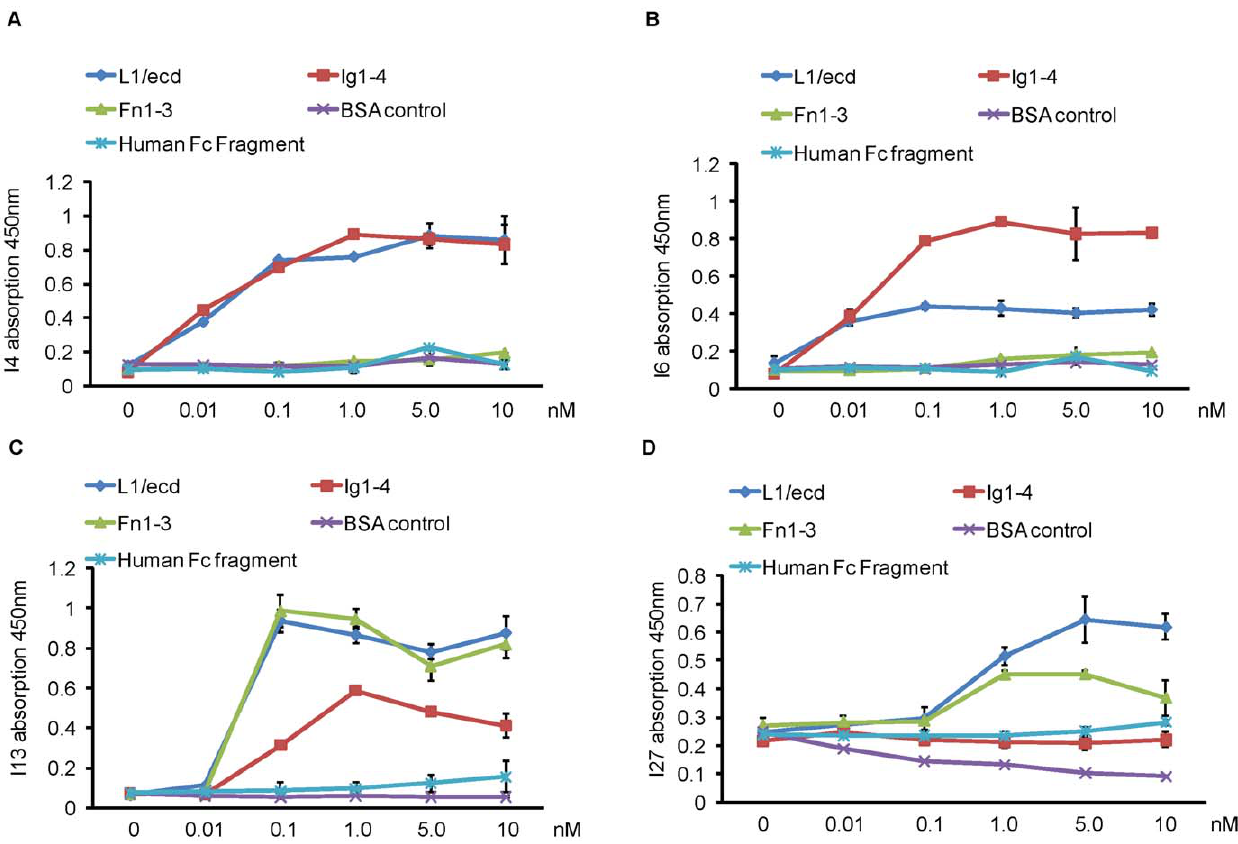
Figure 2. Binding of purified scFvs to L1. Binding of purified scFvs to L1/ecd, Ig1–4, Fn1–3 was determined by ELISA. ( A ) ScFv I4, ( B ) scFv I6, ( C ) scFv I13, ( D ) scFv I27. ScFvs were incubated with substrate-coated L1/ecd, Ig1–4, Fn1–3, human Fc fragment, or bovine serum albumin (BSA) at the indicated concentrations. Bound scFvs were detected with biotinylated antibodies against c-myc followed by incubation with ExtrAvidin-HRP. Data represent mean values 6 SEM from 3 independent experiments.